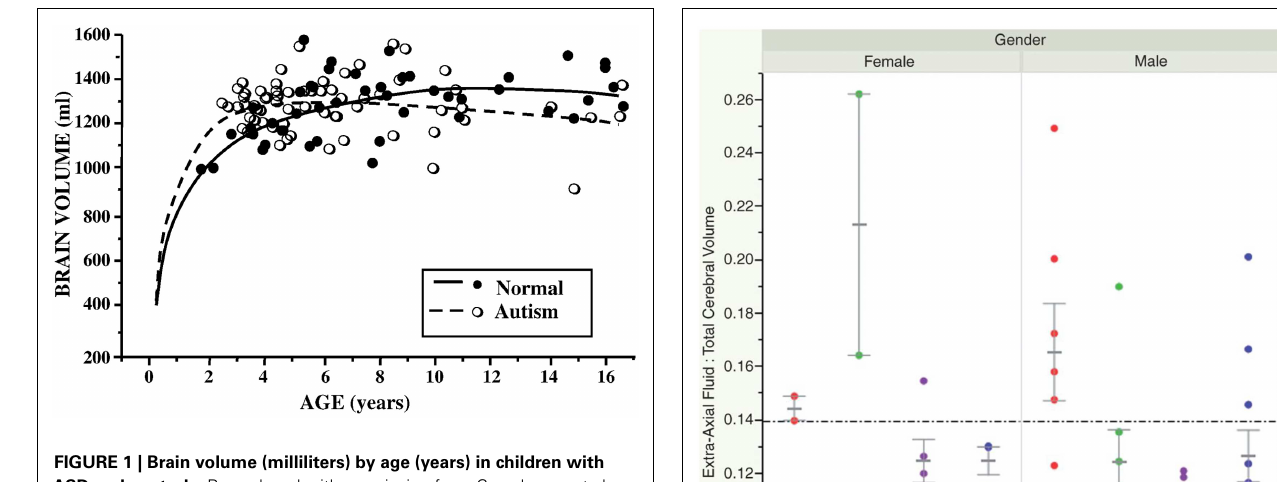
> 0.14 yielded 79% specificity and 78% sensitivity in 12–15